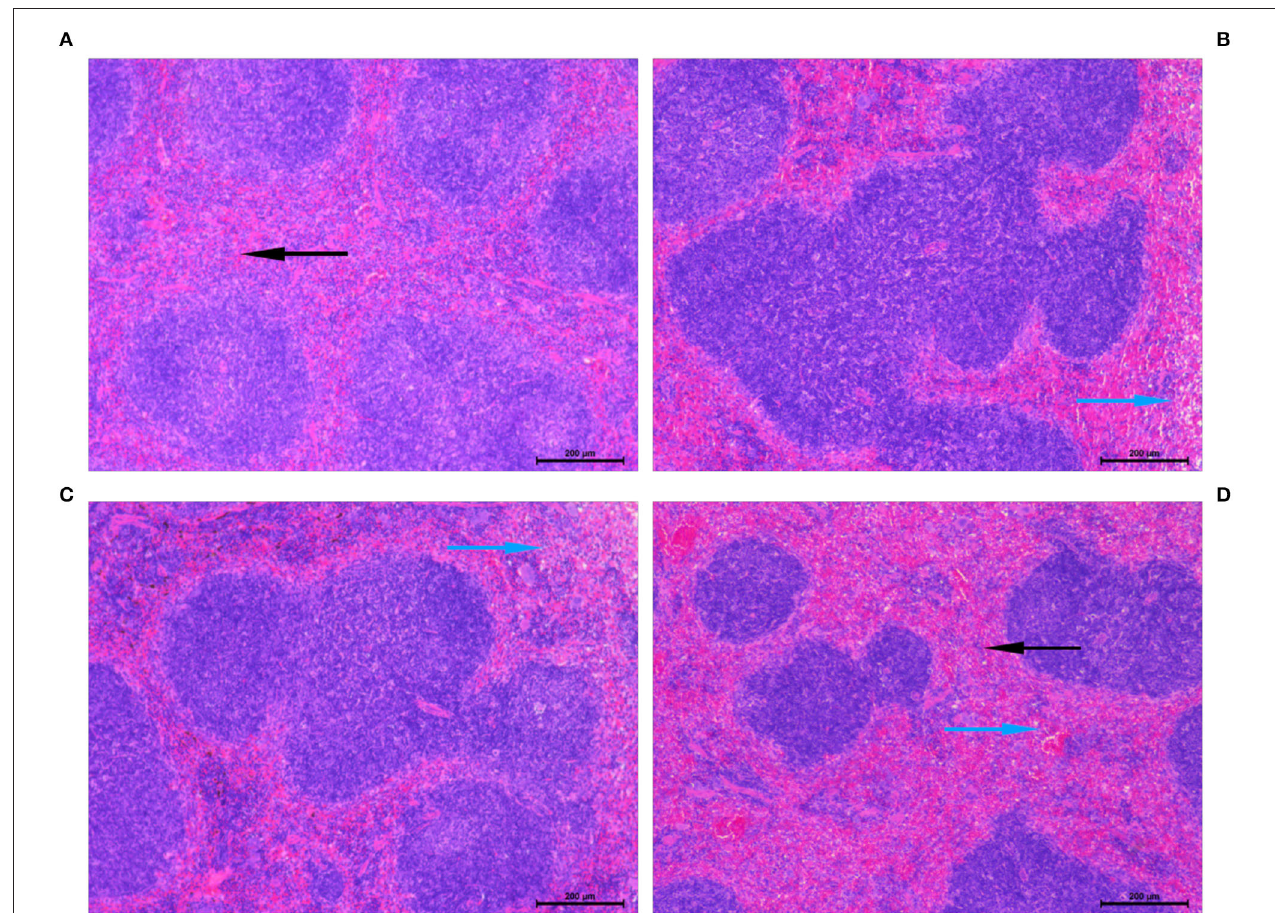
FIGURE 5 | Histopathological lesions were determined in the spleen following fecal peritonitis-induced septic. Representative images showed an improvement in the vital organ injury in mice pretreated with PCP-400. Sections were examined under the microscope at a magnification of 200 × by two separate pathologists. The blue arrows indicate histopathological lesions and the black arrows refer to normal pathological appearance. (A) Sham. (B) FIP. (C) FIP + PCP-200. (D) FIP + PCP-400. FIP + PCP-200 = FIP with PCP 200 mg/kg/day; FIP + PCP-400 = FIP with PCP 400 mg/kg/day. All presented data are a composite of three independent experiments. n = 5 in each